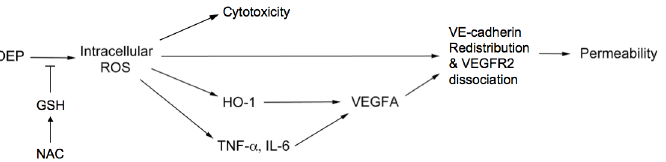
Fig 8. Schematic diagram depicting DEP-induced mechanisms potentially causing vascular permeability. DEPs cause capillary-like endothelial tubes to produce intracellular oxidative stress, which increases vascular permeability by 3 mechanisms: i) direct rearrangement of the cell-cell junctional VE- cadherin network; ii) activation of HO-1, which subsequently causes release of the vascular permeability factor, VEGFA; iii) inducible TNF- α and IL-6 release, which might increase the release of VEGFA independently of the contribution by HO-1. Administration of NAC blocks these sequential cytotoxic effects from the